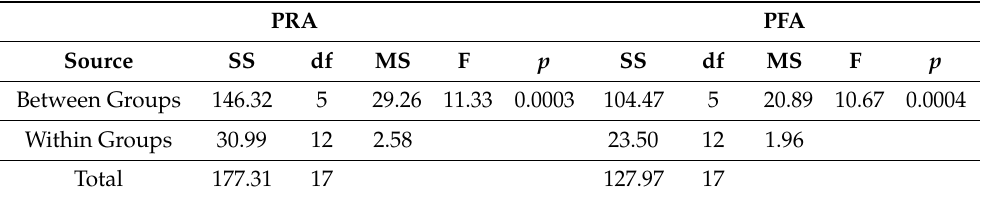
Table 3. ANOVA for root growth upon uprooting after treatment of ANE in PFA and PRA experiments. PRA PFA Source SS